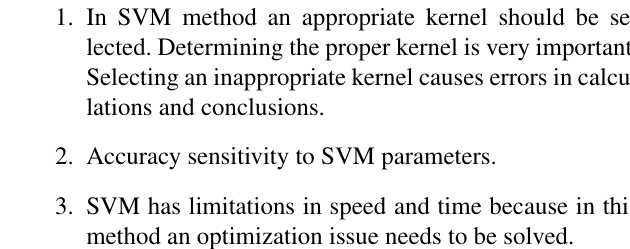
porting vector machine (SVM) technique is a supervised ap- proach which can be compared to multivariate regression analysis because both methods are supervised and based on regression